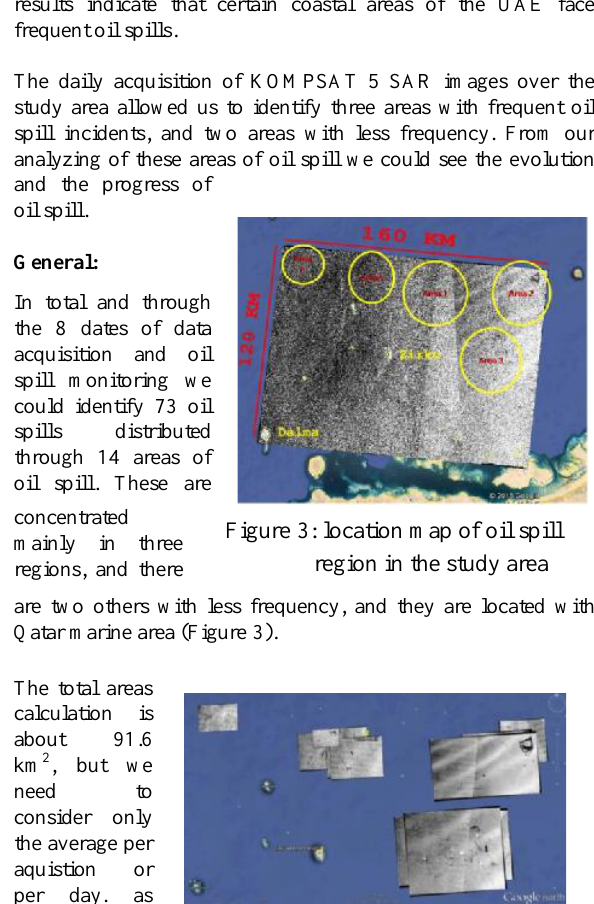
Figure 4: Main area of oil spill